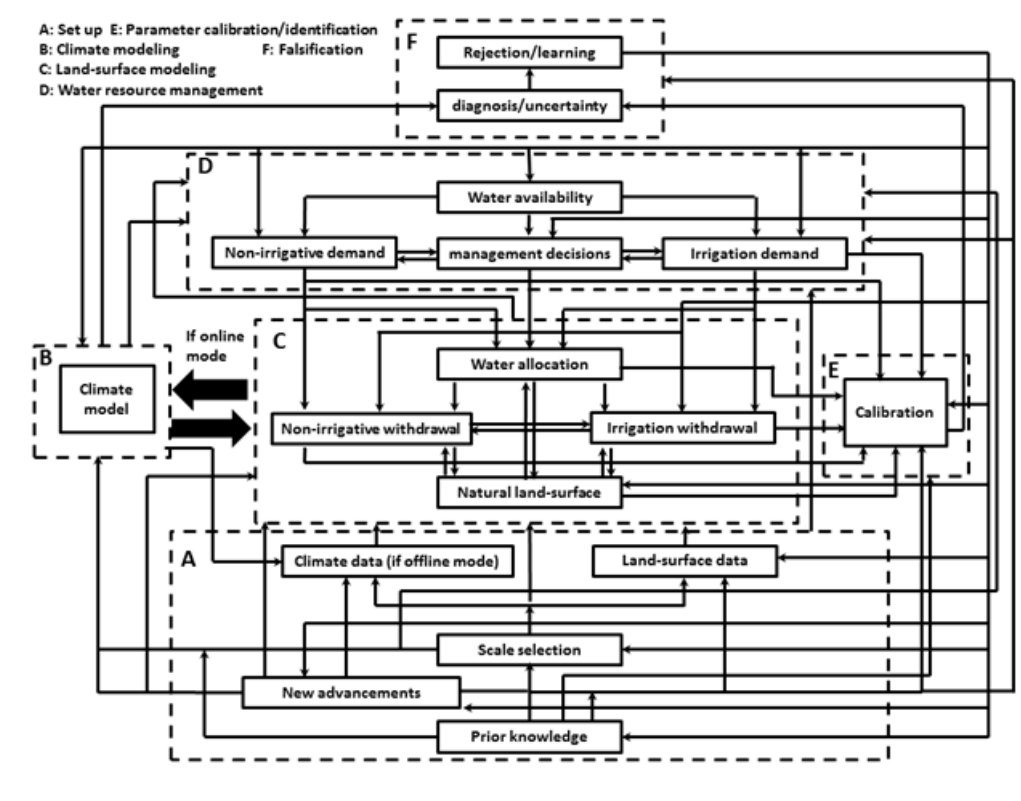
Figure 2. A modular framework for improving the inclusion of water resource management in LSMs through building, testing and falsifying multiple working hypotheses.